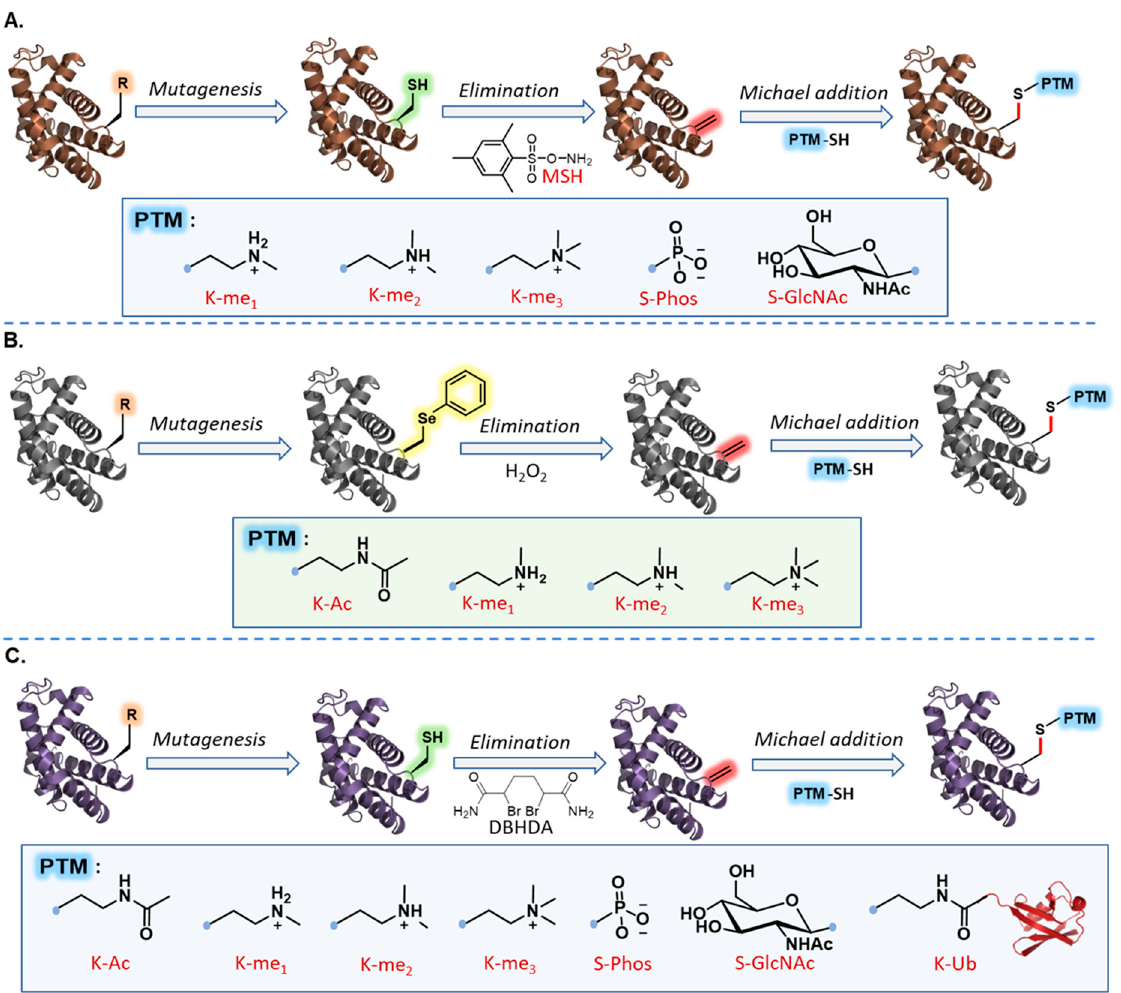
Figure 4. Chemical mutagenesis via dehydroalanine coupled via Michael addition chemistry. ( A ) Chemoselective transfer of multiple PTM mimics via Cys elimination using MSH followed by Mi- chael addition: mono-/di-/trimethylation, phosphorylation, and glycosylation. ( B ) Chemoselective transfer of PTM mimics to Lys via Sec elimination followed by Michael addition: mono-/di-/tri- methylation and acetylation. ( C ) Chemoselective transfer of multiple PTM mimics via Cys elimina- tion followed by Michael addition: mono-/di-/trimethylation, phosphorylation, glycosylation, acet- ylation, and